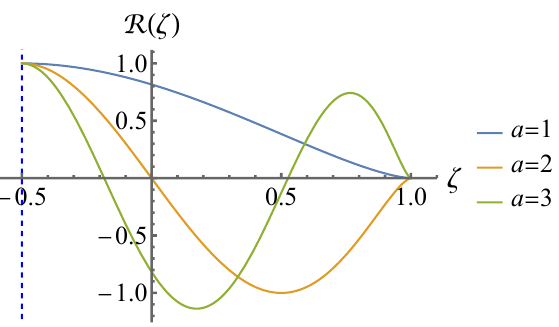
Figure 3 . The first three eigenfunctions R ( ζ ) for d = 3 , m 2 = 0 and the brane located at ζ = ζ ∗ = − 1 / 2 , corresponding to θ = 2 π/ 3 . R ( ζ ) is normalized so that R ( ζ ∗ ) = 1